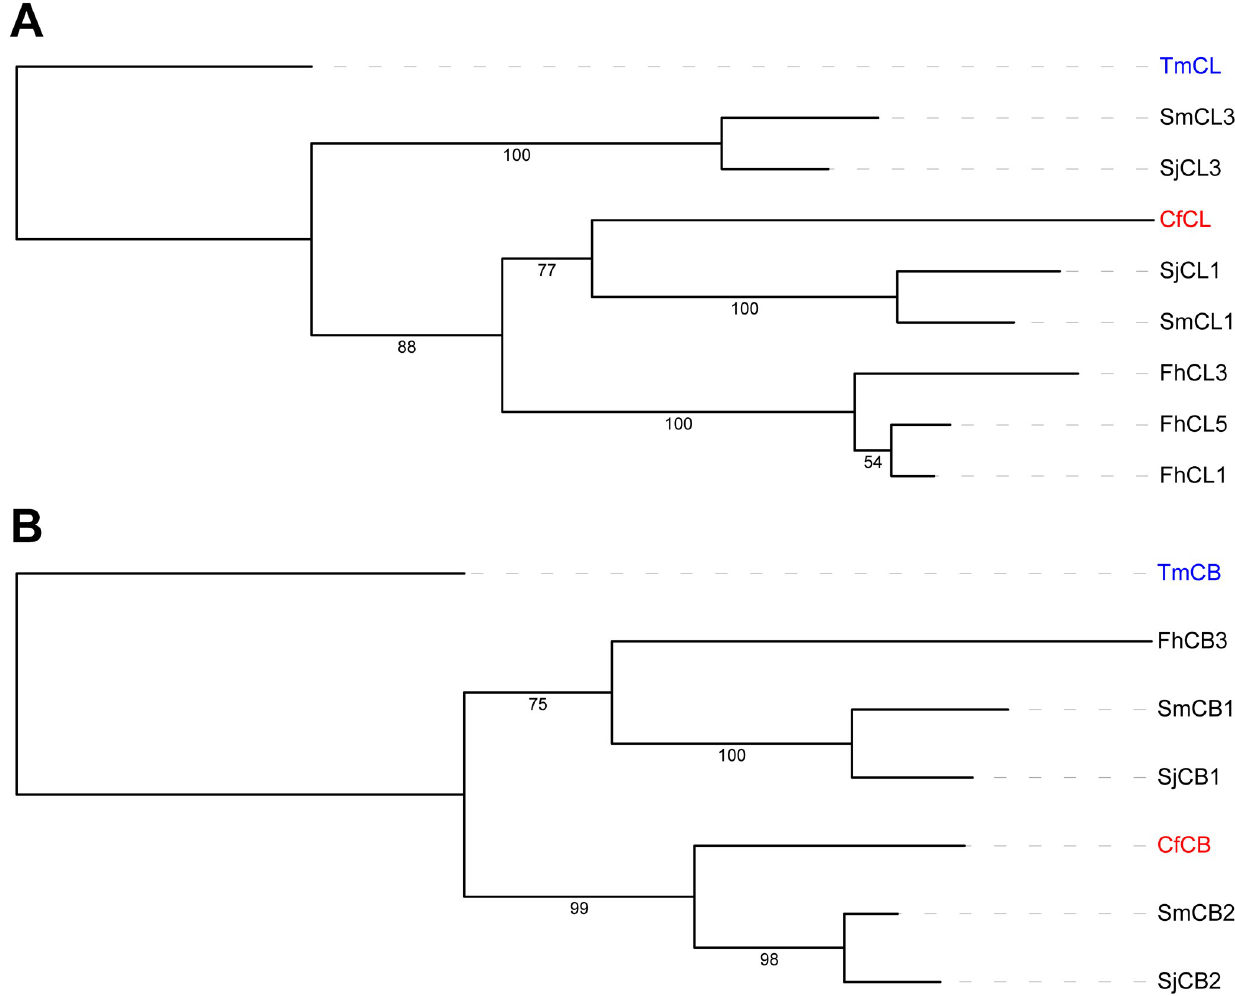
Fig 4. Phylogenetic tree of Cardicola forsteri cathepsins. Outgroup-rooted maximum likelihood tree of the cathepsins from Cardicola forsteri (shown in red) in Table 4 with cathepsins from Schistosoma mansoni , Schistosoma japonicum , Fasciola hepatica , and Thunnus maccoyii (as the outgroup in blue). Bootstrap values are shown on the branches. (A) Cathepsins L, including: SmCL1 (Q26564), SmCL3 (B4XC67), SjCL1 (C1LBR4), SjCL3 (C1LJC3), FhCL1 (Q7JNQ9), FhCL3 (B9VXS1), FhCL5 (A0A2H4PKA2), TmCL (XP_042278099.1). (B) Cathepsins B, including: SmCB1 (P25792), SmCB2 (Q95PM1), SjCB1 (P43157), SjCB2 (Q7Z1I6), FhB3 (A7UNB2), TmCB